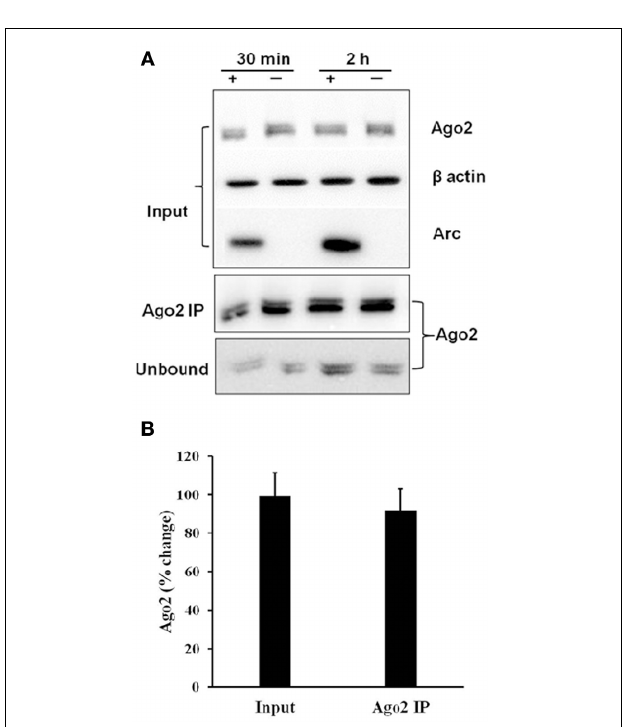
FIGURE 5 | Stable expression of Argonaute 2 protein during LTP. (A) Immunoprecipitation of Ago2 30 and 120min post-HFS. Representative